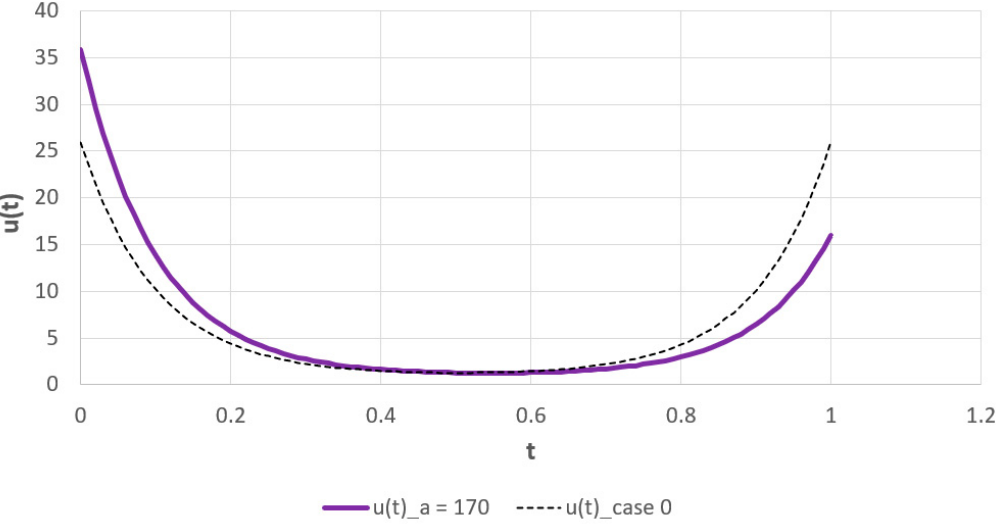
Figure 15. The optimal time path of u in Dynamic case 2.